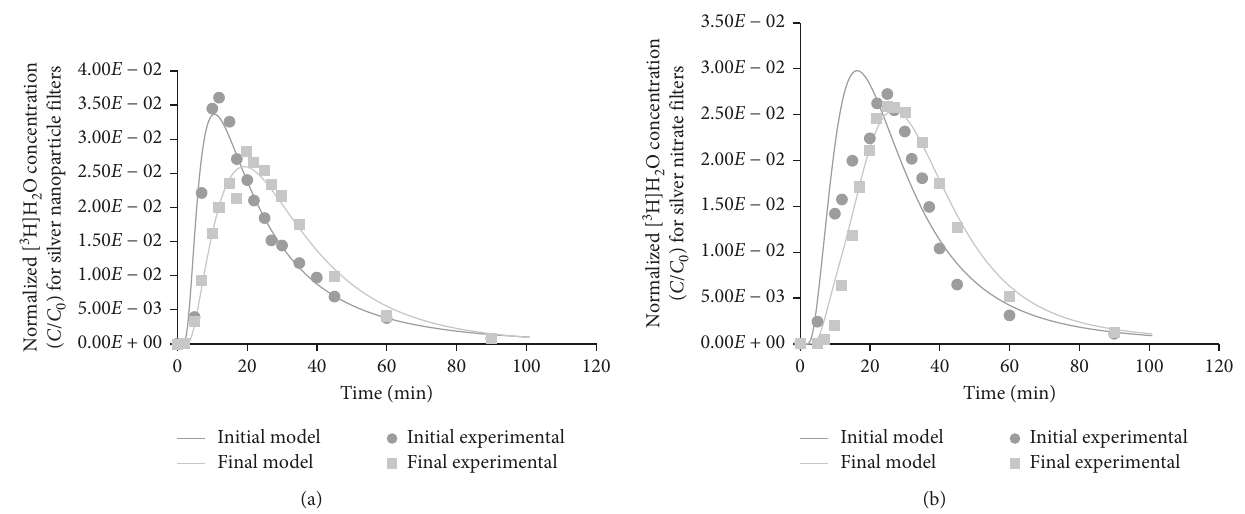
Figure 6: Results of [ 3 H]H 2 O transport experiments and simulations through (a) silver nanoparticle ceramic filters and (b) silver nitrate ceramic filters (b). Tracer experiments and simulations are shown for experiments conducted at the start and end of a two-week period of constant flow of synthetic groundwater containing E. coli